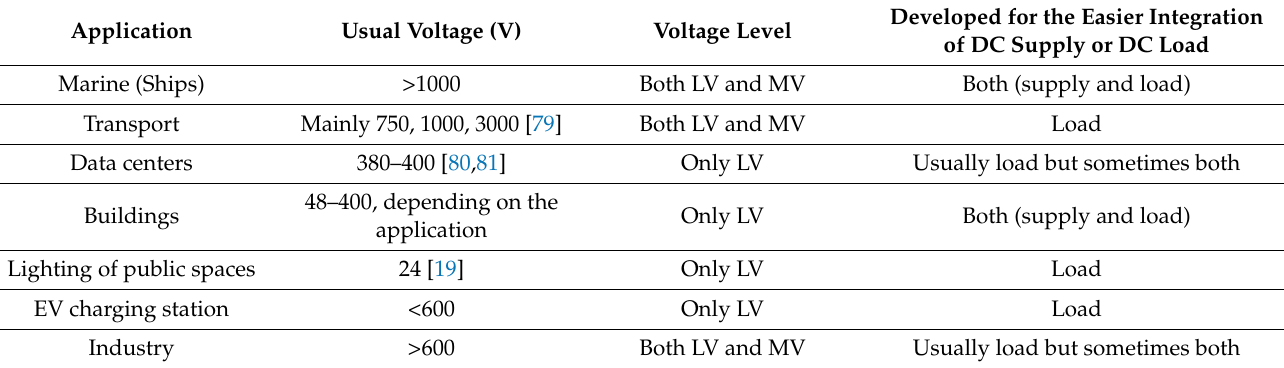
Table 5. Applications of DC MGs (Data from